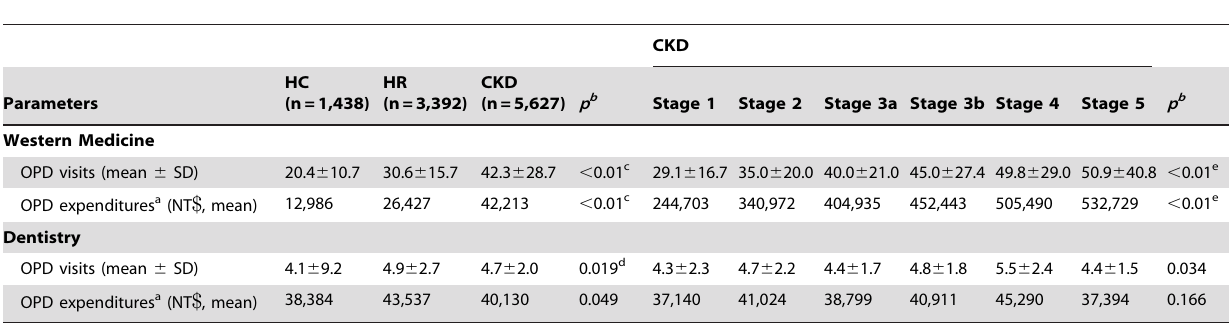
Table 3. The average annual number of OPD visits and expenditures per person in WM and DENT among eligible patients and different CKD stages from 2000 to